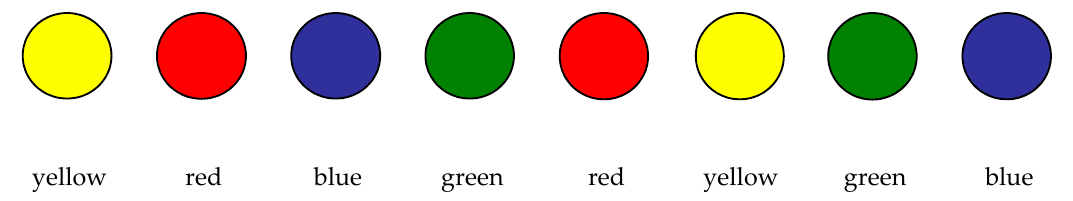
Figure 1. Circles of colors presented as baseline task for Stroop tasks.